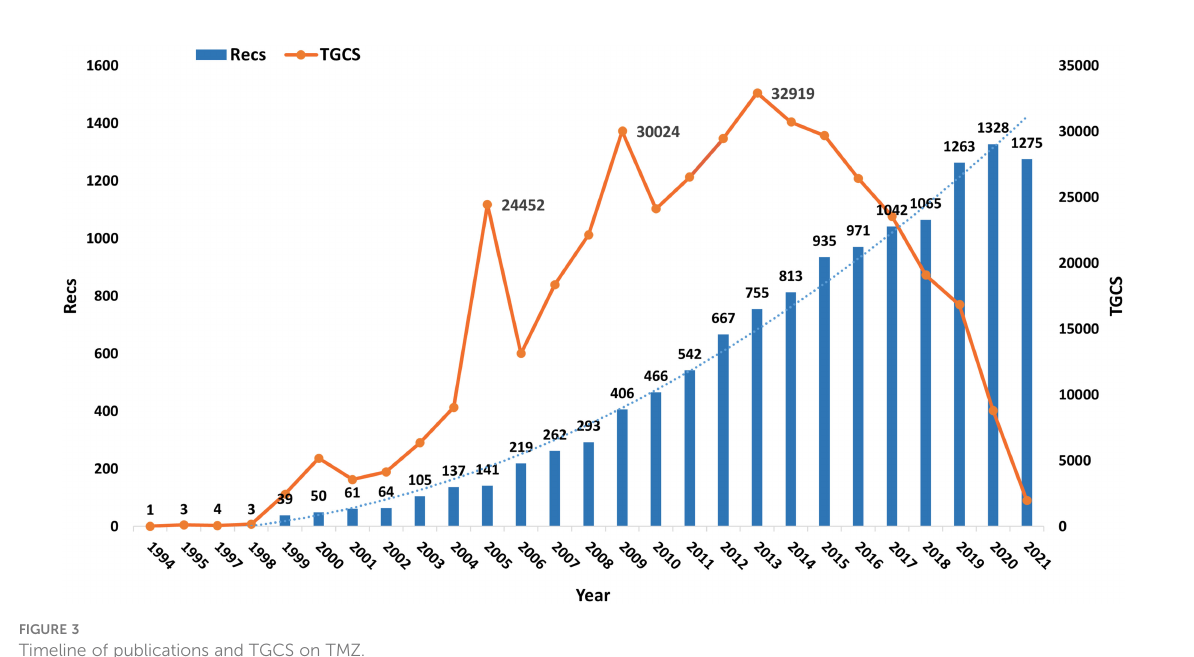
FIGURE 3 Timeline of publications and TGCS on